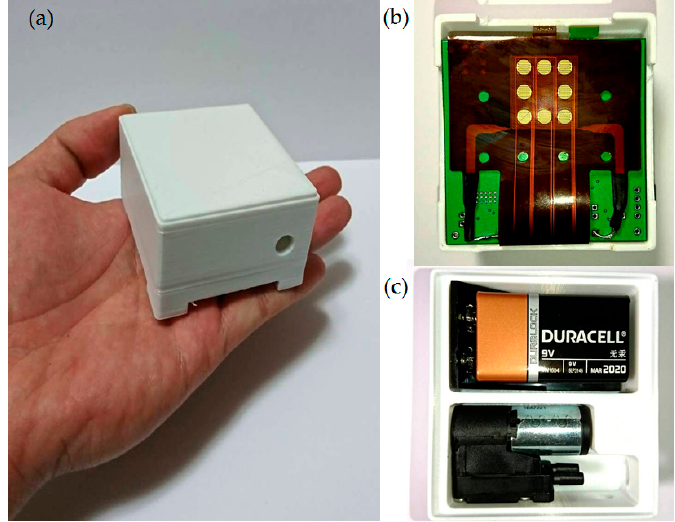
Figure 5. Prototype of wearable and wireless gas-sensing system. ( a ) Photograph of wearable and wireless gas-sensing system; ( b ) Front photograph of gas sensor array; ( c ) Reverse side photograph of micropump and battery.